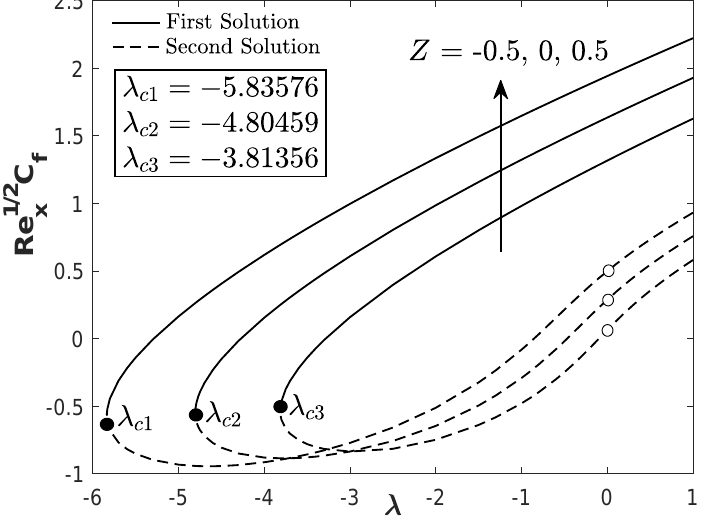
Figure 5. Re x 1/2 C f towards λ when φ 2 = 0.005 and d = 0.5 with various Z